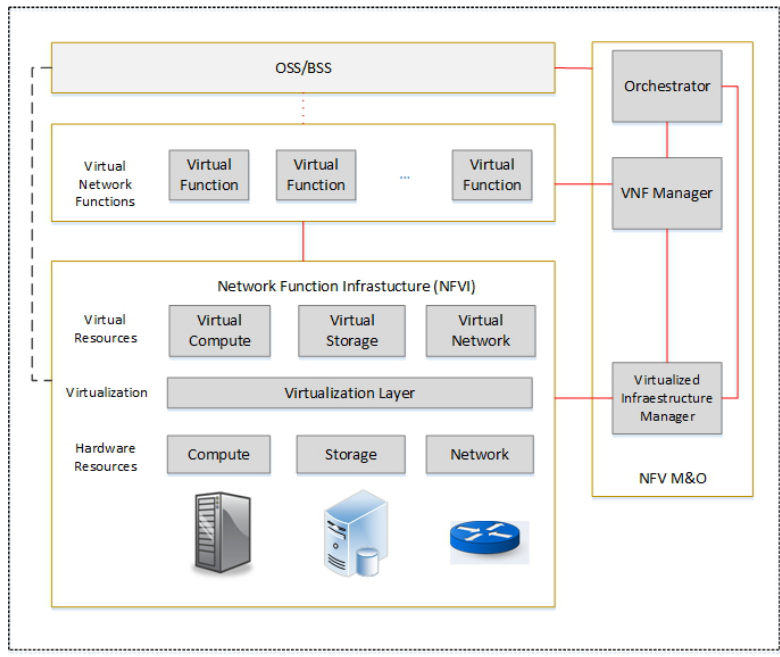
Figure 2. NFV Reference